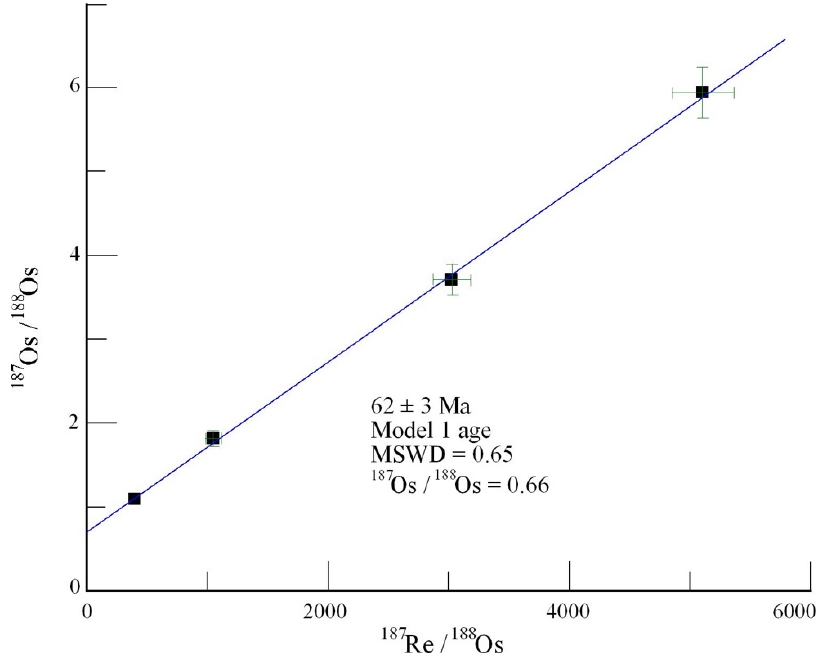
Figure 11. 187 Os / 188 Os vs. 187 Re / 188 Os isochron diagram of massive sulfide ores from drill Core samples of Cerattepe VMSD, Re-Os isochron age with 62 My ± 3 Ma.